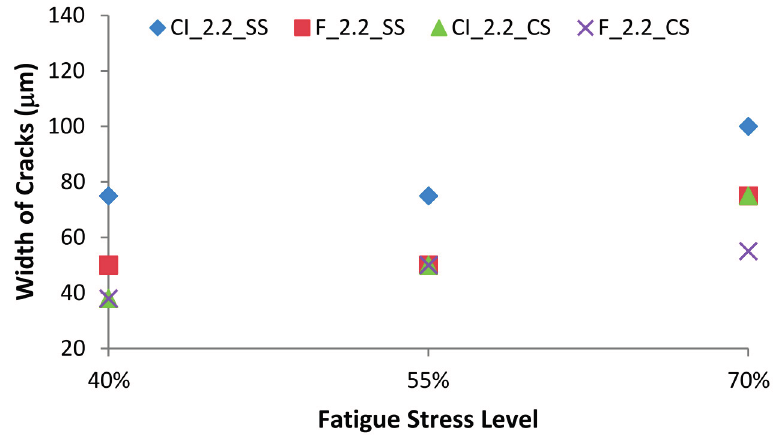
Figure 5. Average numbers of cracks at each fatigue stress level.